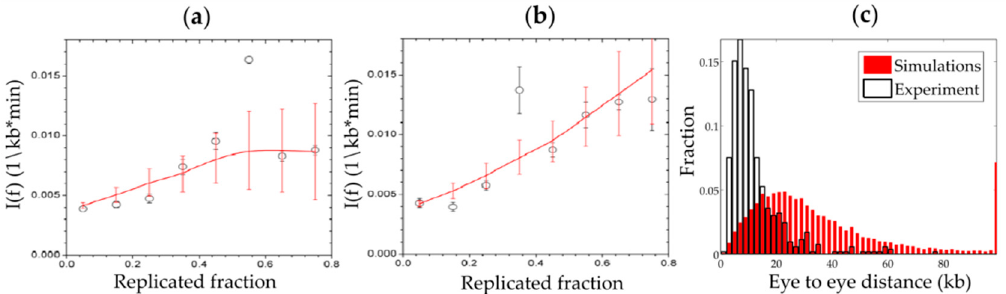
Figure 4. Numerical simulation of the intra-S phase checkpoint action reproduces the temporal but not the spatial program of origin firing. The frequency of origin initiation and the replication of eye-to-eye distance distribution were extracted from DNA combing experiments in the absence or presence of Chk1 activity. The model discussed in the text was simulated by using a Monte Carlo technique. The plots represent the experimental (black) and numerical (red) frequency of initiation in ( a ) the presence or ( b ) the absence of Chk1 activity from [69], and ( c ) the eye-to-eye distance distribution in the presence of Chk1 activity (unpublished data).